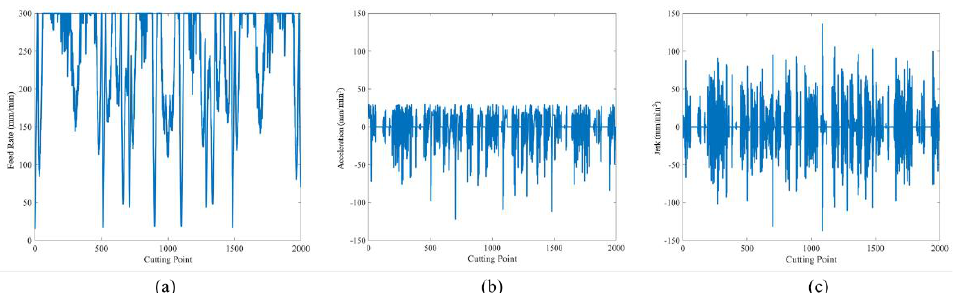
Figure 24. Cutting butterfly shape using method by Luan et al. [9]: ( a ) feed rate, ( b ) acceleration, and ( c ) jerk.